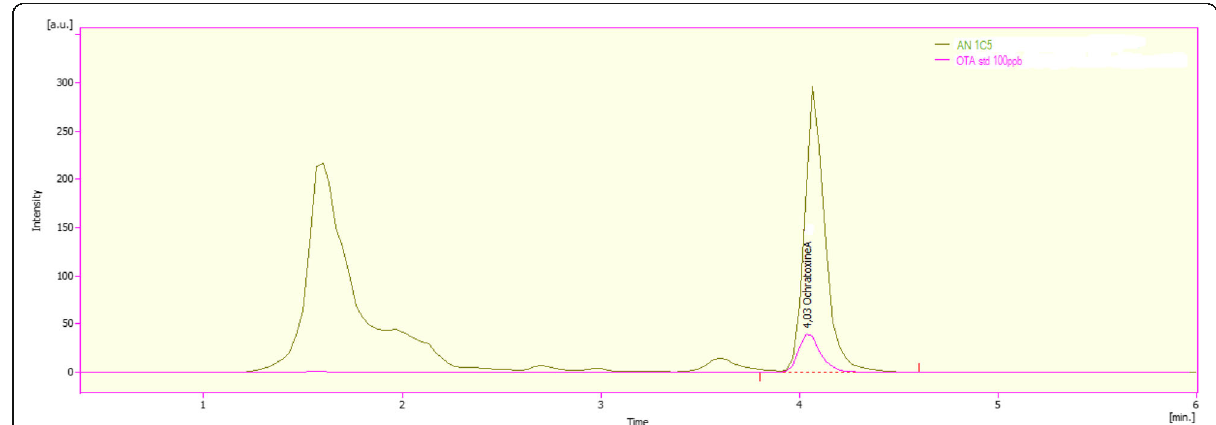
Fig. 3. HPLC chromatograms of one ochratoxigenic isolate (1C5) and OTA standard (100